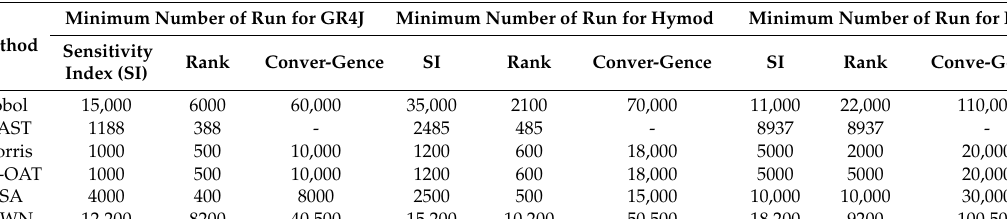
Table 5. Minimum number of runs for computing Sensitivity Indices, ranking and reaching convergence for di ff erent Sensitivity Analysis (SA) method.